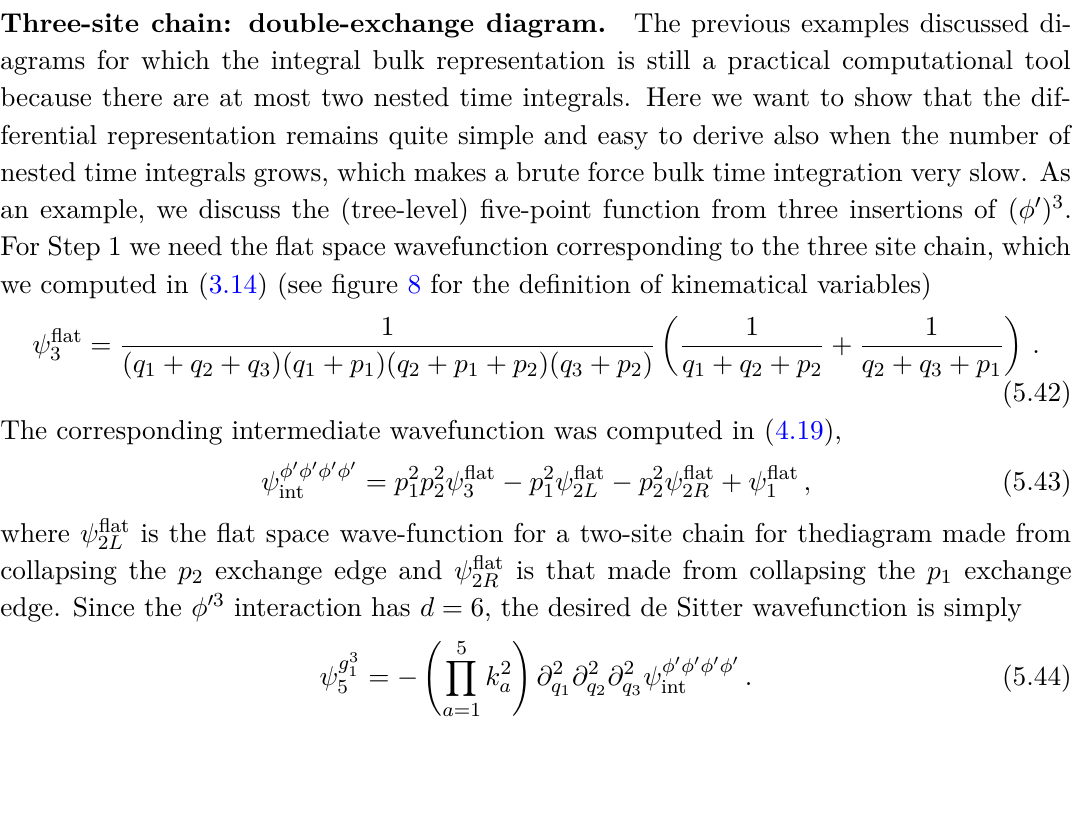
from the double exchange of the same 5